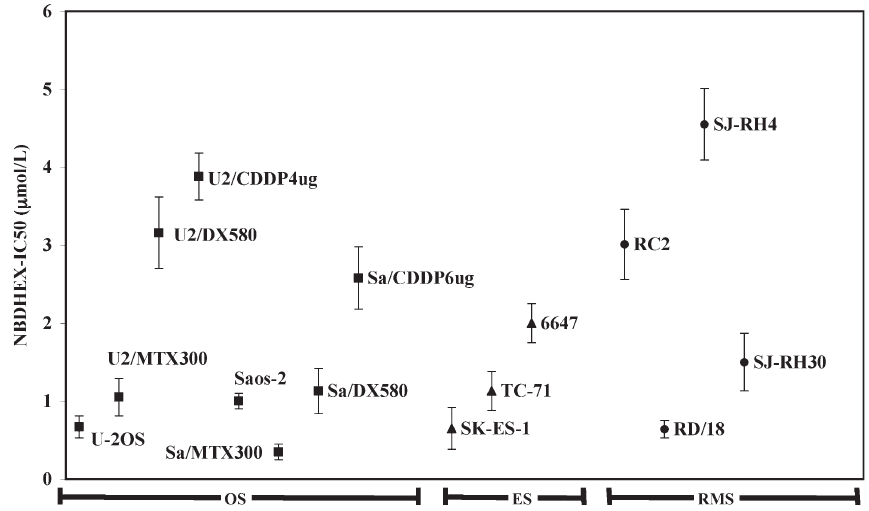
Fig. 4. In vitro sensitivity to NBDHEX of the human osteosarcoma, Ewing’s sarcoma and rhabdomyosarcoma cell lines. The graph shows IC50 values (drug concentration resulting in 50% inhibition of cell growth) after treatment with NBDHEX for 96 hours (osteosarcoma cell lines) or 72 hours (Ewing’s sarcoma and rhabdomyosarcoma cell lines). Data are shown as mean value ± standard deviation of three different experiments. OS, osteosarcoma; ES, Ewing’s sarcoma; RMS,